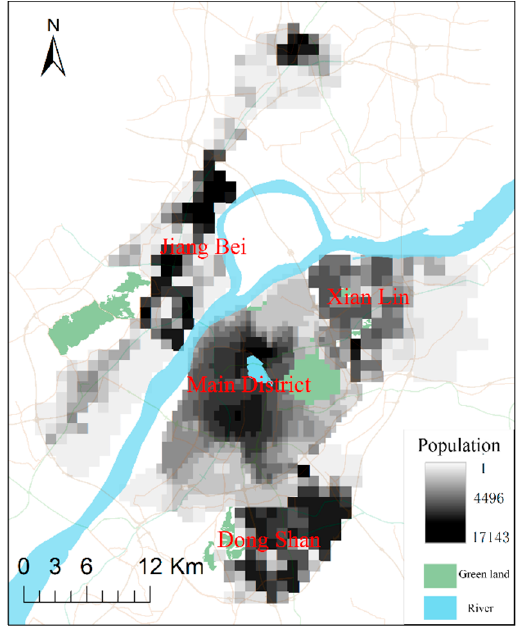
Figure 2. Healthcare service facilities in the study area. Figure 3. Population in the study area. Figure 3. Population in the study